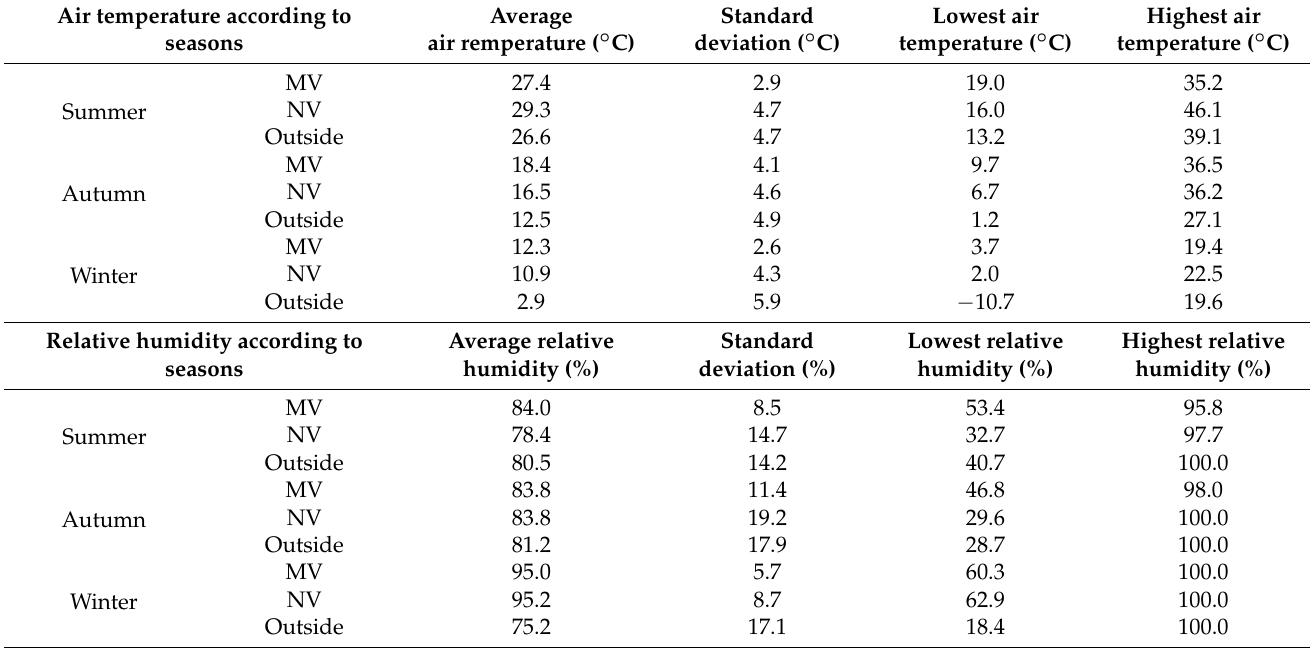
Table 4. Date information according to growing period during experimental